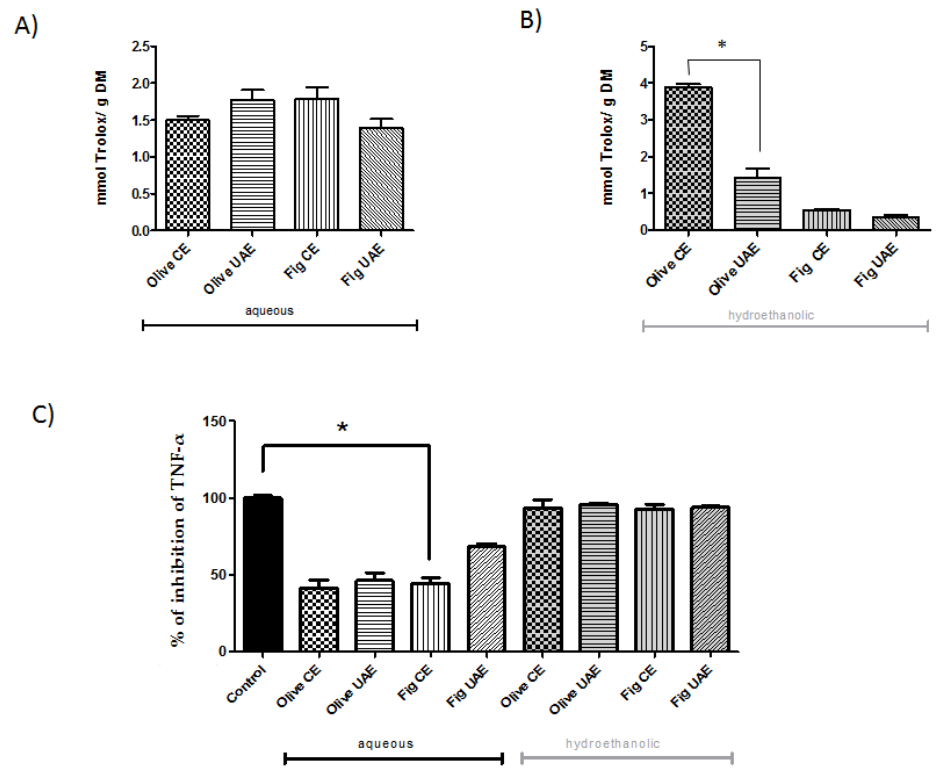
Figure 3. Antioxidant capacity and anti-inflammatory e ff ects of the fig and olive leaves extracts. Antioxidant capacity (TEAC; Trolox Equivalent Antioxidant Capacity (mmol Trolox / g dry matter)) in ( A ) aqueous and ( B ) hydroethanolic (50:50, v / v, ethanol: water) extracts. ( C ) The e ff ect of plant extracts on the TNF- α inhibition determined in olive and fig leaves after conventional (CE) or ultrasound-assisted (UAE) extraction. Di ff erences ( p < 0.05) between treatments are denoted by *.